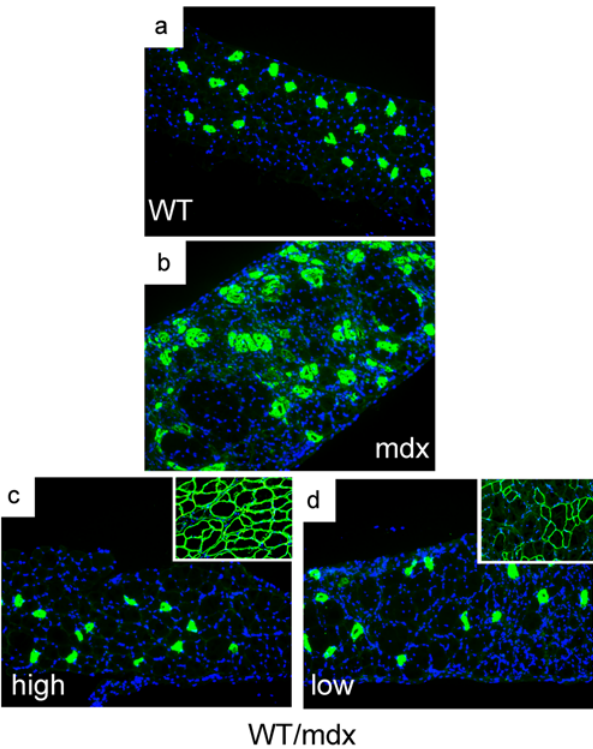
Figure 8. Slow MHC is not clustered in the skeletal muscle of WT/mdx chimeric mice. a–d, diaphragms from WT (a), mdx (b) and 10–30% WT/mdx chimeric (c, d) mice were sectioned and stained for slow MHC (green). c and d, insets, adjacent sections of (c) and (d) respectively from the same diaphragm stained for dystrophin. DAPI (blue) demarcates nuclei. Magnification: 200 6 . Experiments were performed with diaphragm muscles of 2 animals (n=2) per group (WT, mdx and 10–30% WT/mdx).